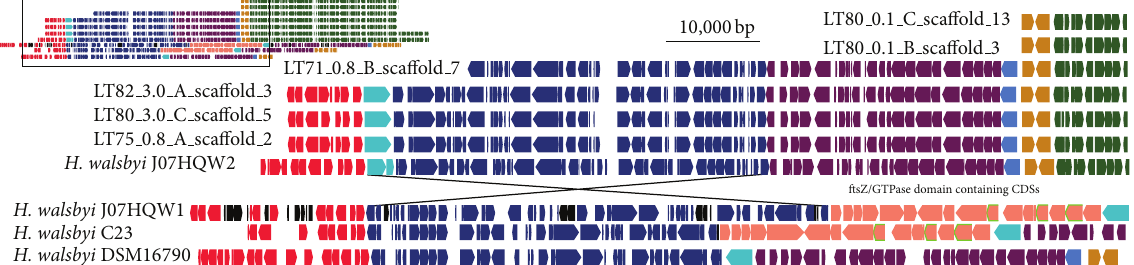
Figure 1: Inset: a gene map of the region spanning 600,000–770,000 bp along the H. walsbyi J07HQW1 genome, the corresponding regions in the other H. walsbyi genomes, and the environmental contigs. Full image: an expanded view of the region denoted in the inset. Syntenic regions are marked by matching colors. Pink arrows denote the 16 CDS segment identified as unique to the H. walsbyi J07HQW1 and C23 genomes. Environmental contigs use a long form identification number whereby the first item is the sample (e.g., LT71), the second item is the filter fraction (e.g., 0.8 𝜇 m), the third item is the phylogenetic bin (e.g., B), and the fourth item is the scaffold number (e.g., scaffold 13). The regions represented on the gene map from each genome are as follows: J07HQW1, 610,420–769,897 bp; J07HQW2, 2,470,010–2,313,700 bp; C23, 510,000–630,000 bp; DSM16790, 510,000–610,000